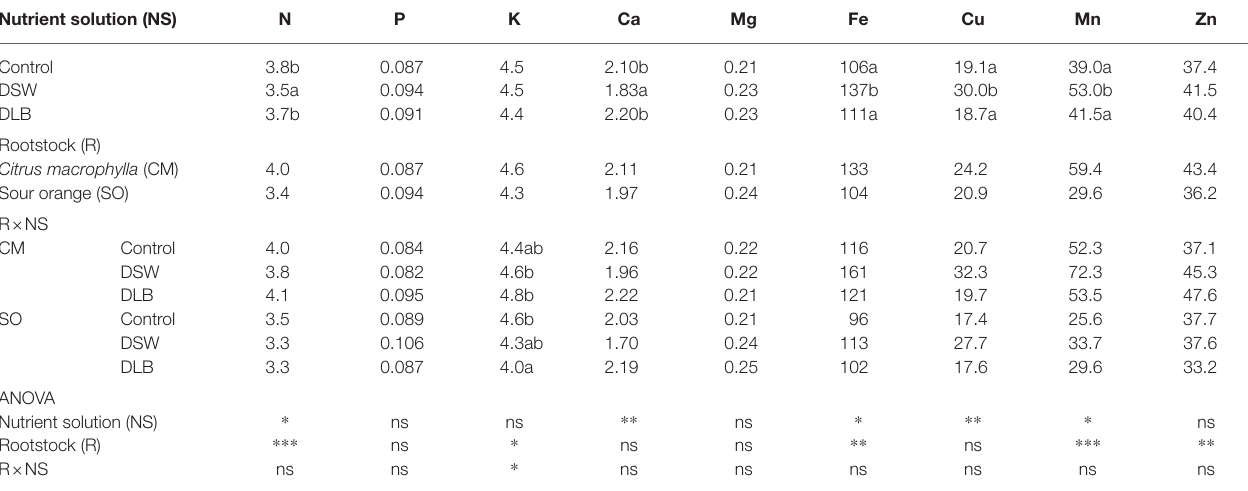
TABLE 4 | Effects of 7 months of irrigation with nutrient solutions of different characteristics—Control, DSW, and DLB—and the rootstock on the leaf mineral nutrition of ‘Verna’ lemon plants grown on two rootstocks, Citrus macrophylla (CM) and sour orange (SO). Nutrient solution (NS)